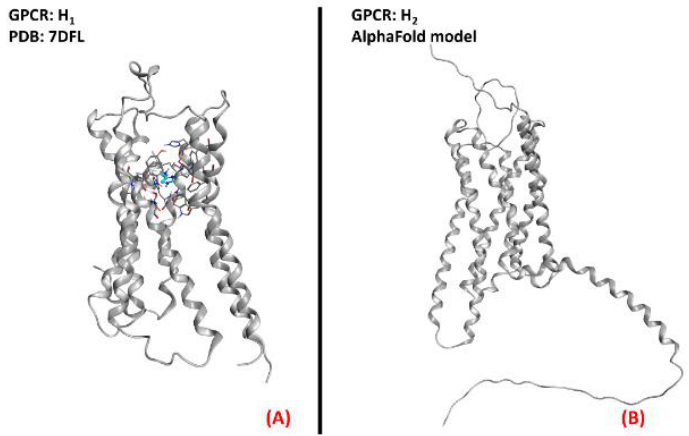
Figure 19. Representation of the three-dimensional structures of the histamine receptors that could be considered for ALS treatment. ( A ) The H 1 receptor (sourced from the Protein Data Bank, PDB code: 7DFL [132], method: cryo-EM, resolution: 3.30 Å) and ( B ) the H 2 receptor (with no experimentally resolved structure available, the model sourced from the AlphaFold [133] database is presented).The images were created and rendered with MOE. The H 3 and H 4 receptors both lack experimentally resolved structures, but their AlphaFold models are available.